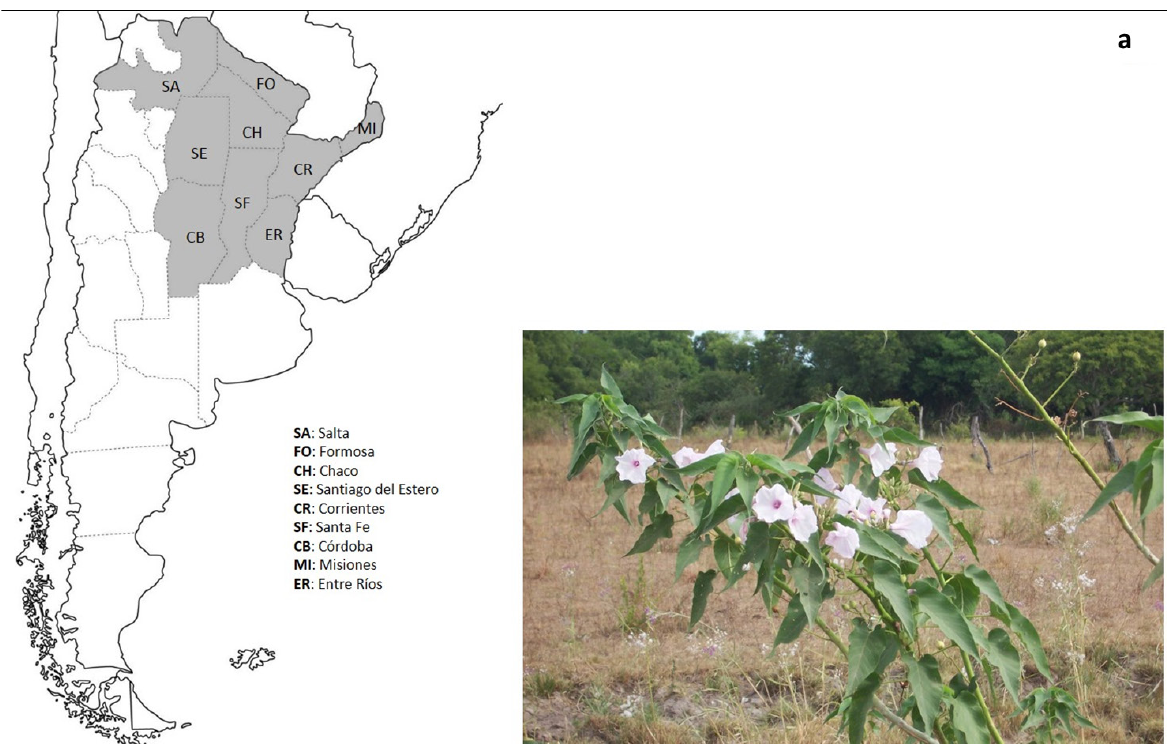
Figure 2a. Distribution of Ipomoea carnea subsp. fistulosa in